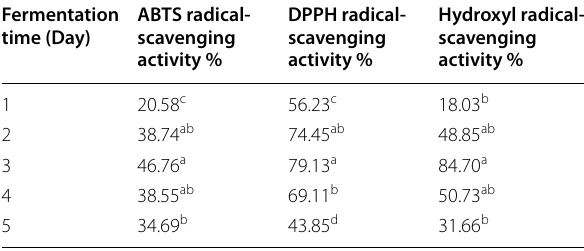
Table 3 The antioxidant activity of cinnamon– S. cerevisiae fermentation mixture at different initial pH values with 10 7 CFU, 35 ˚C for 3 d